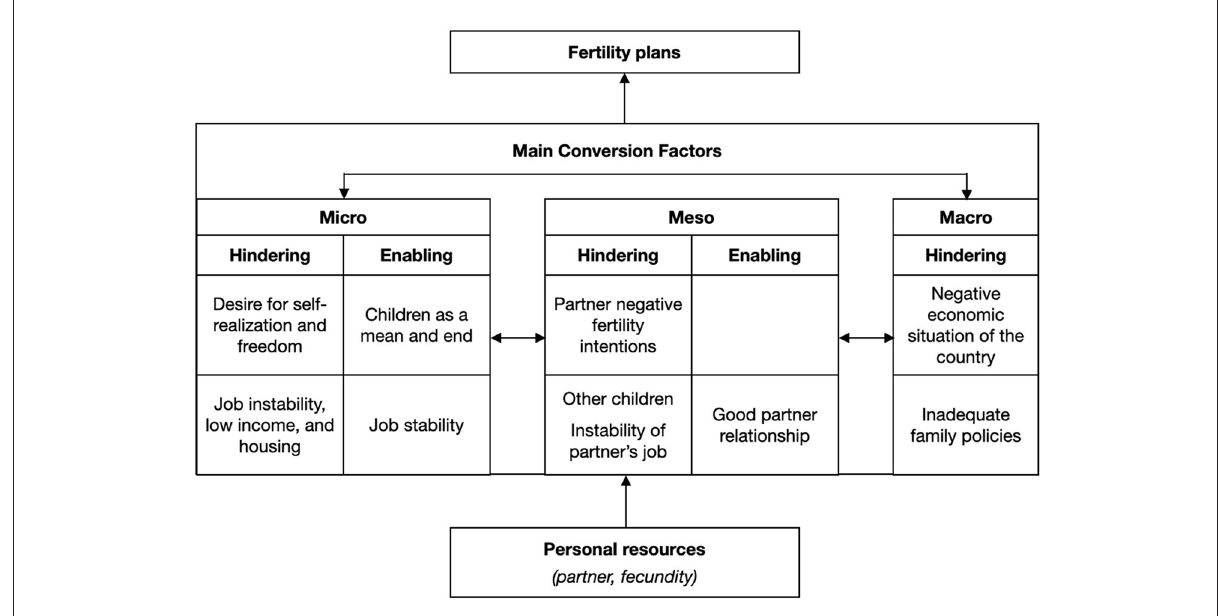
FIGURE2 The main conversion factors of fertility